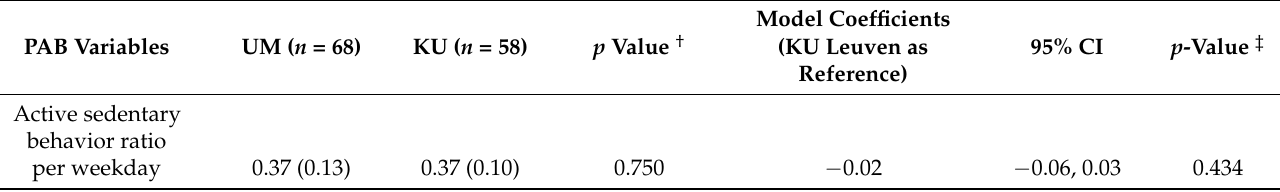
Table 3. Students’ average physical activity behavior data at UM and